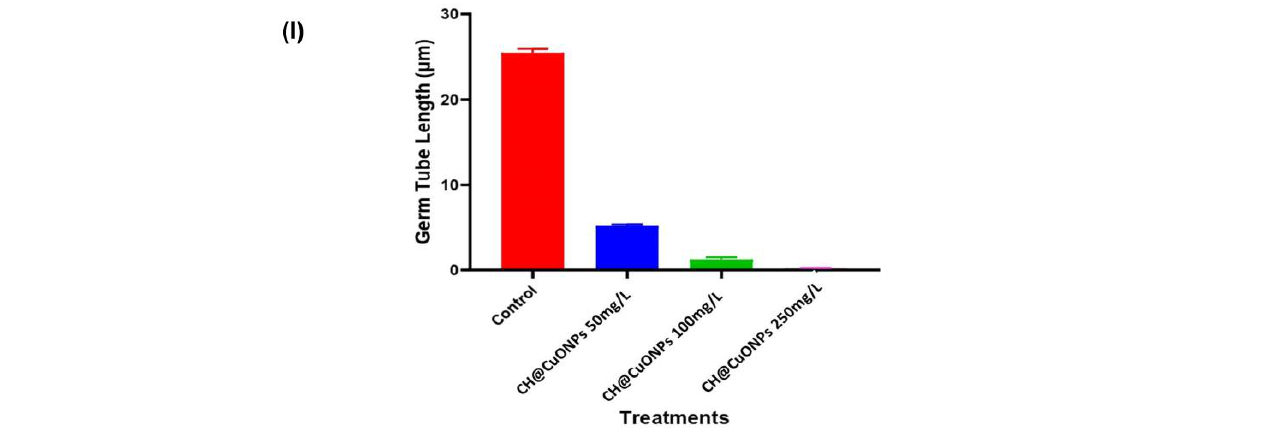
Figure 3. Effect of CH@CuO NPs concentrations on B. cinerea conidial cells treated with sterile water (control) ( A ), ( B – D ) incubated in CH@CuO NPs at 50, 100 and 250 mg/L for 8 h, respectively; ( E ) conidial cells of B. cinerea incubated in sterile water for 8 h and stained by propidium iodide (control) ( F – H ) conidia cells of B. cinerea stained by propidium iodide after treatment for 8 h with CH@CuO NPs at 50, 100 and 250 mg/L, respectively. ( I ) Germ tube length of B. cinerea in response to treatment with CH@CuO NPs at concentrations 50, 100 and 250 mg/L compared to control.